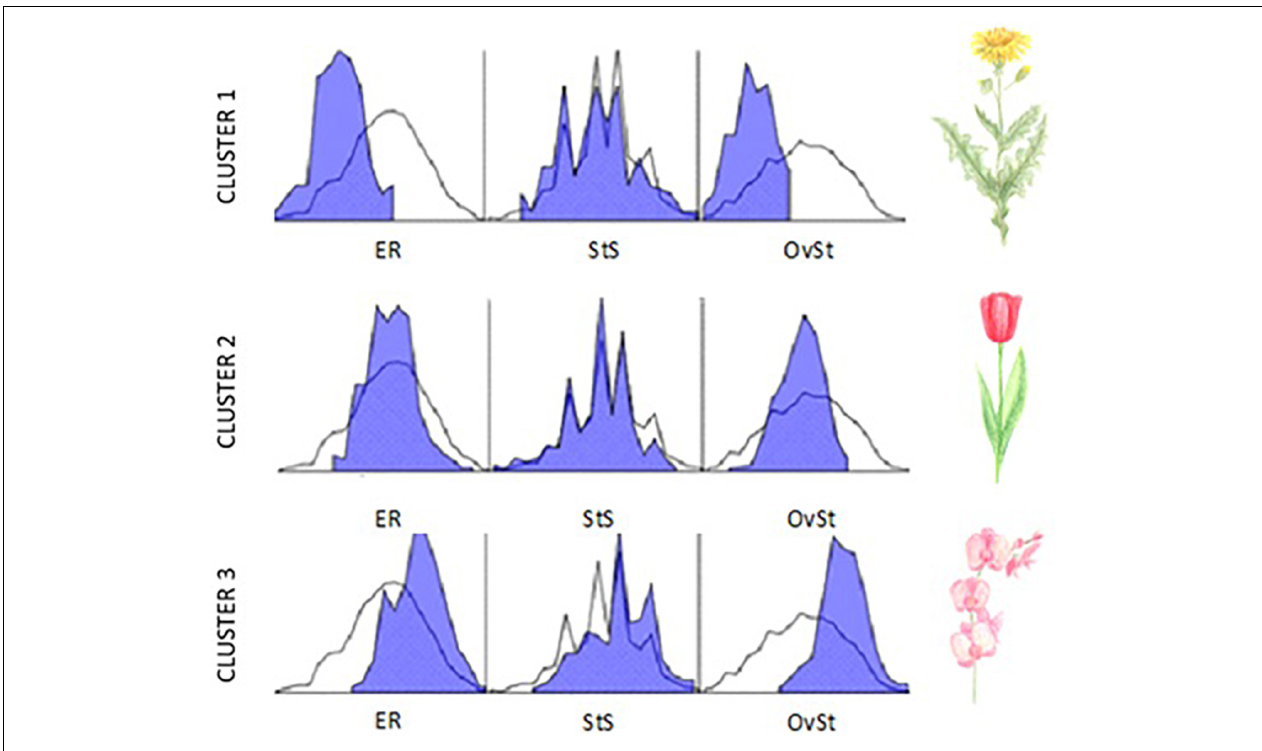
FIGURE 2 | The HSPS subscales’ distribution in each cluster (axis X – scores in each subscale; axis Y – frequency; blue area presents the distribution for the cluster; white area presents the distribution for the general sample). ER, Emotional Reactivity ; StS, Sensing the Subtle ; OvSt, Overstimulation .